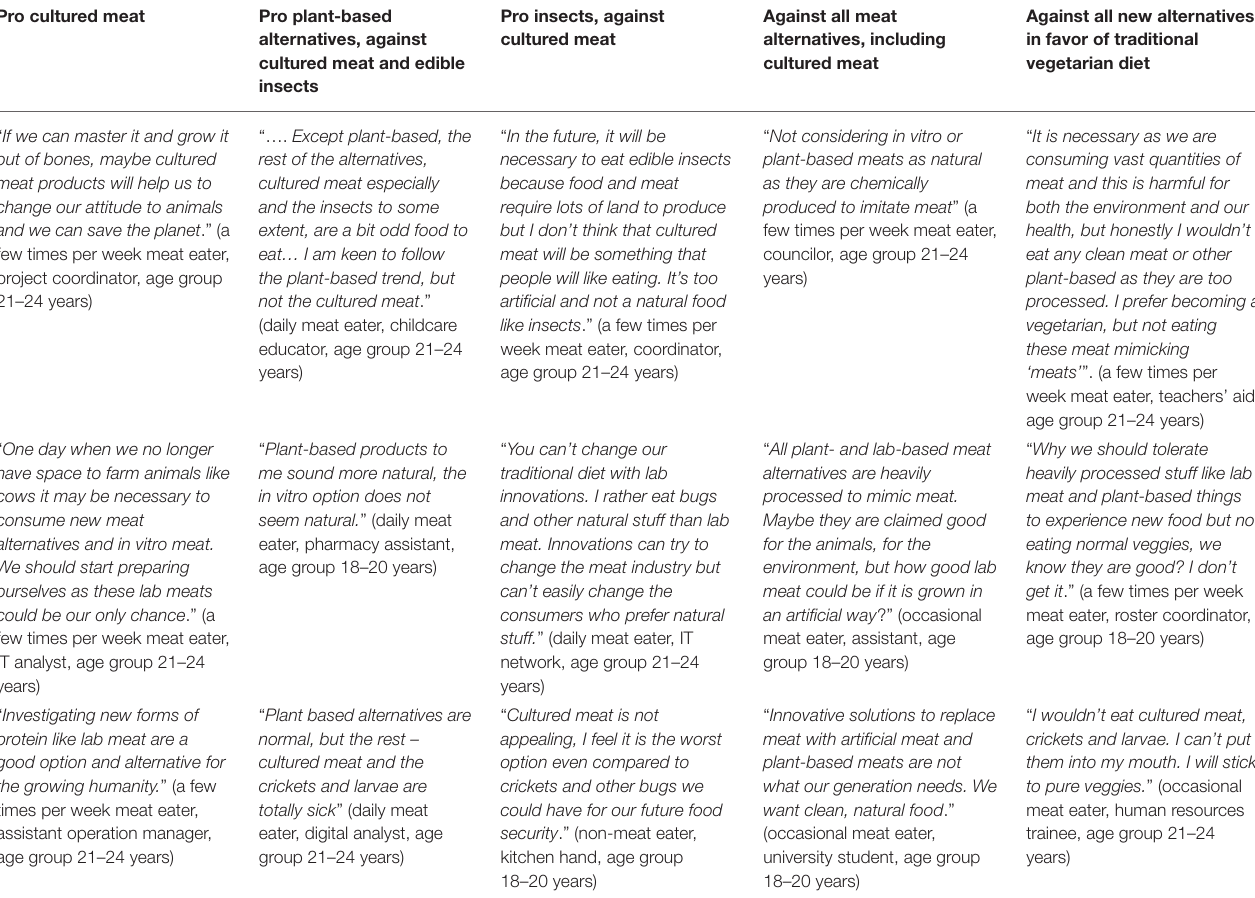
TABLE 12 | Cultured meat vs. alternatives according to Sydney Gen